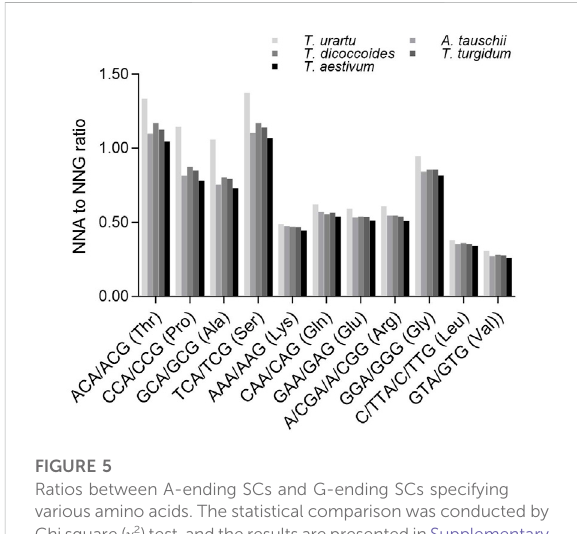
FIGURE 5 Ratios between A-ending SCs and G-ending SCs specifying various amino acids. The statistical comparison was conducted by Chisquare( χ 2 )test,andtheresultsarepresentedinSupplementary Table S8. The difference between the ratios for Ala, Pro, Ser, Thr and those for Arg, Glu, Gly, Leu, Lys, Val in a species was calculated with a two-sample Student ’ s t -test ( p <